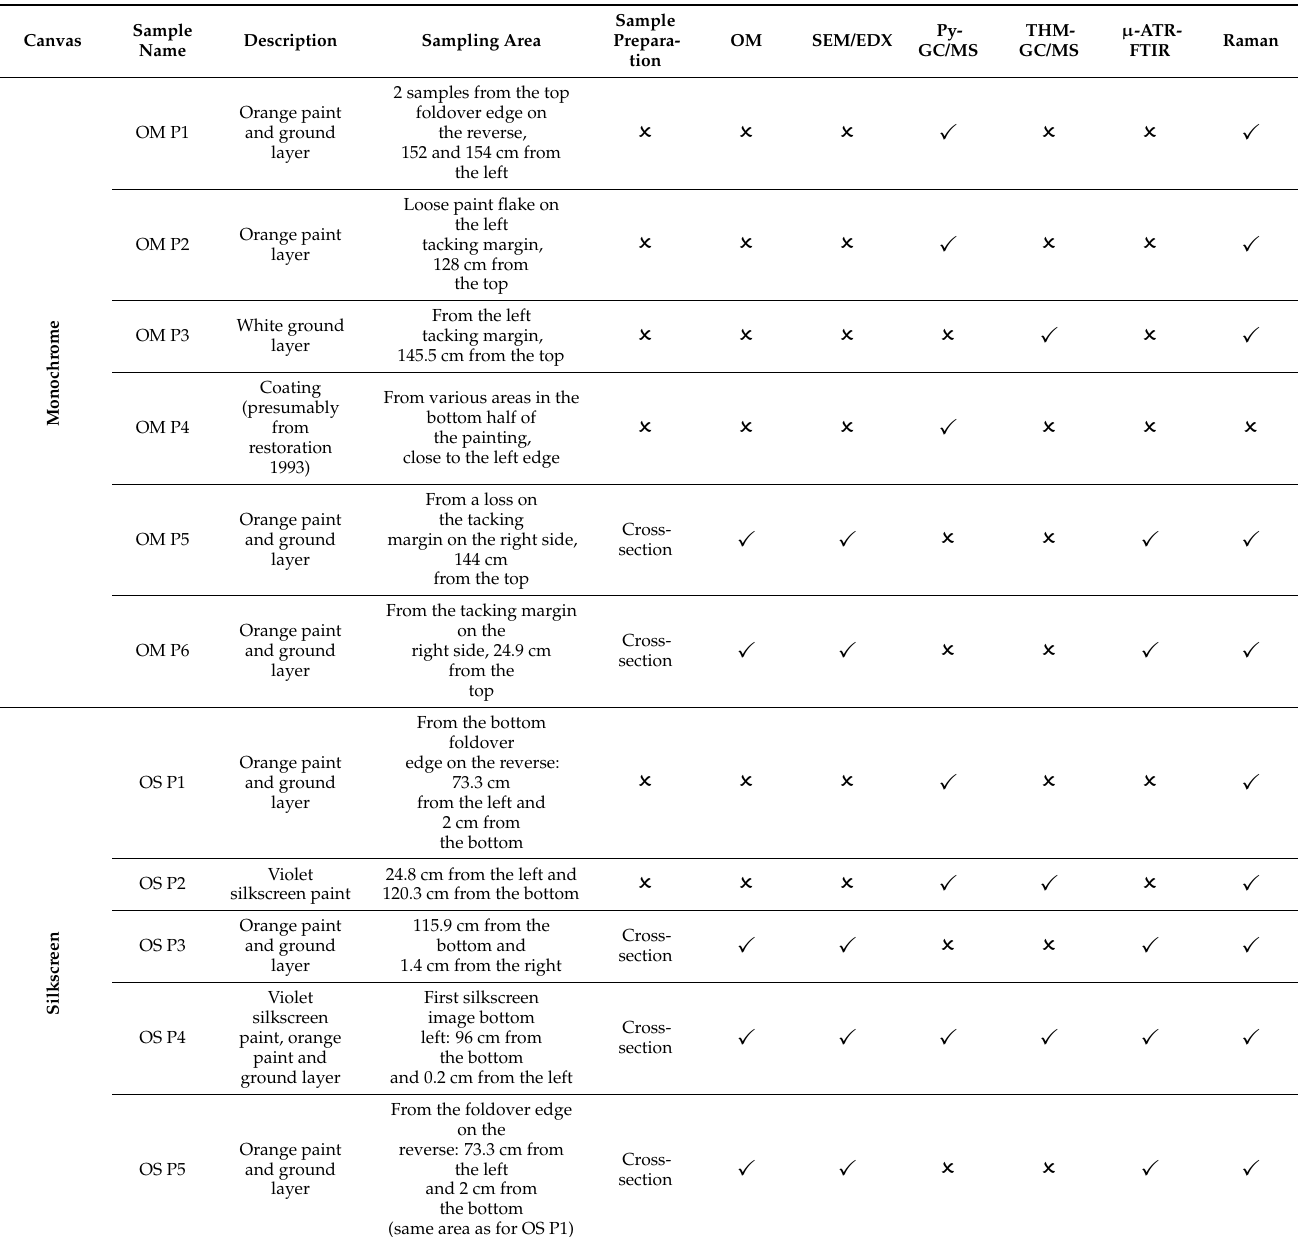
Table 1. List of the samples taken from the monochrome and silkscreen canvases of “ Orange Car Crash ” by Andy Warhol, including the names, description, sampling area, preparation type, and the employed analytical techniques used for their investigation. = performed; = not performed.